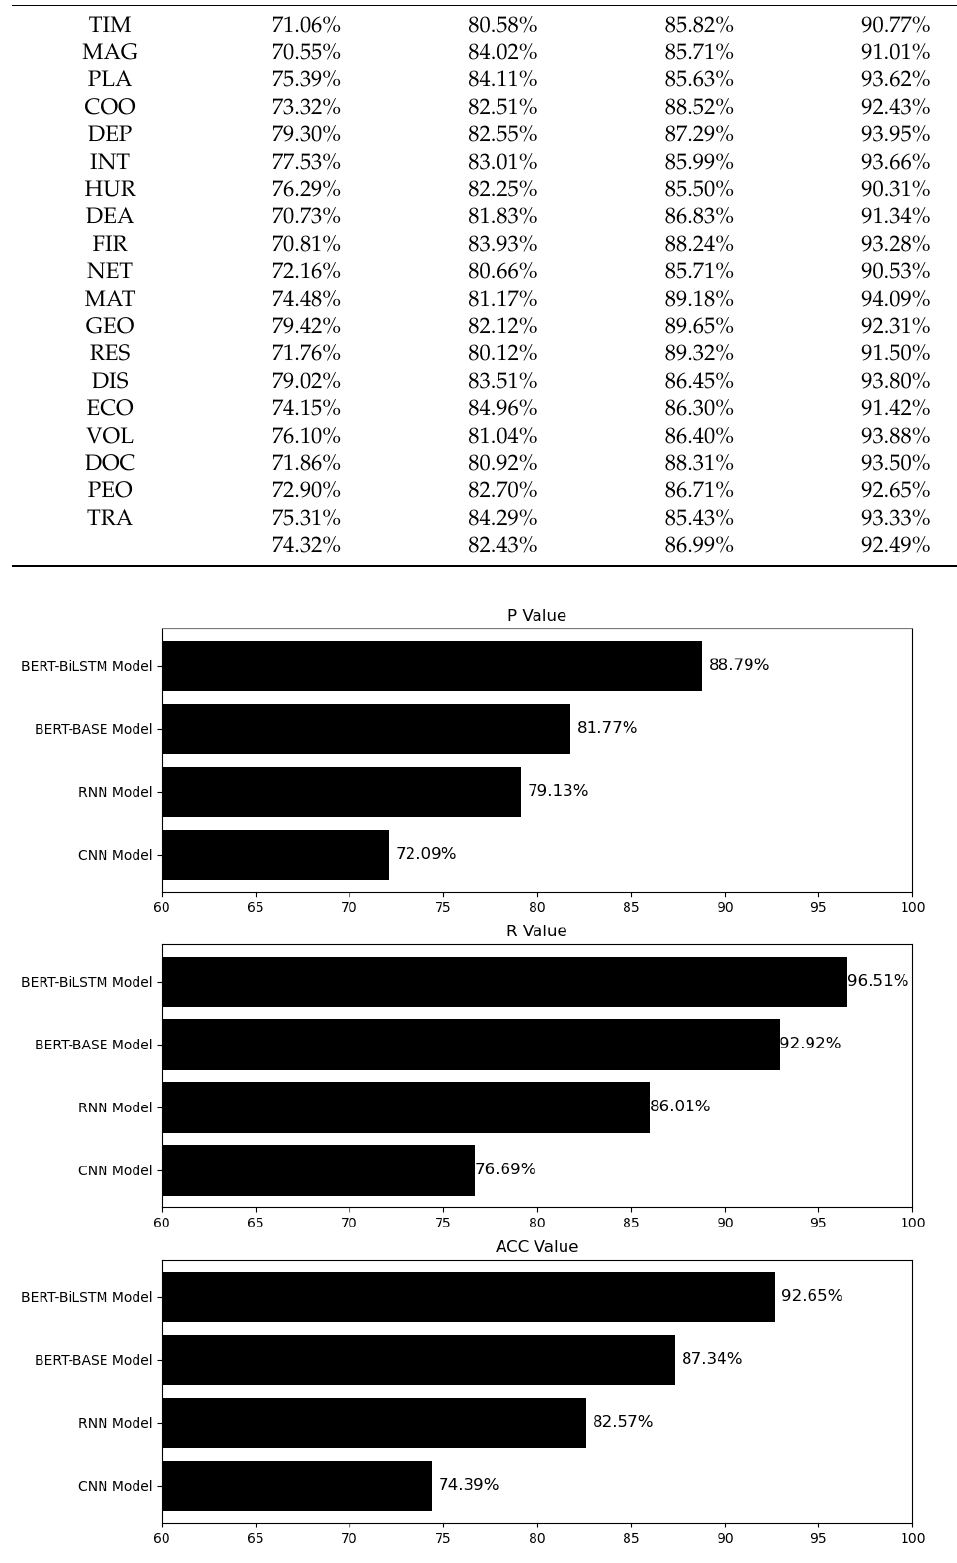
Figure 6. Experimental results for precision, recall, and